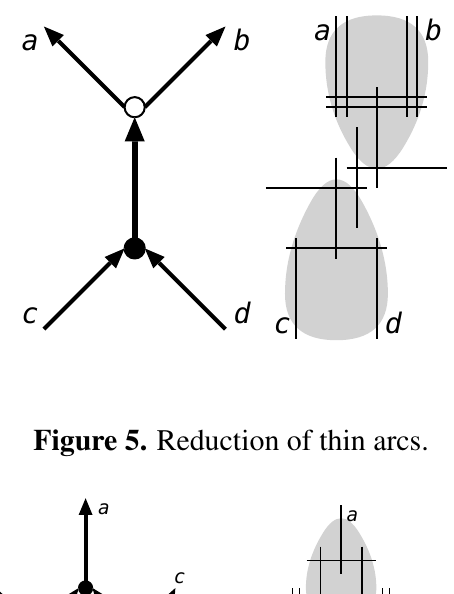
Figure 4. Reduction of thick arcs.